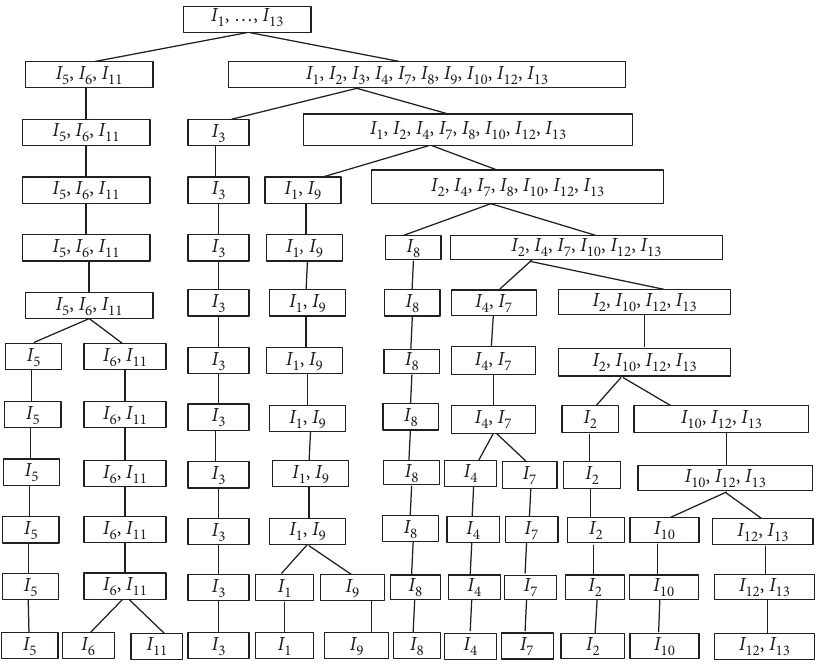
Figure 1: Cluster analysis of average insertion of 9 points.